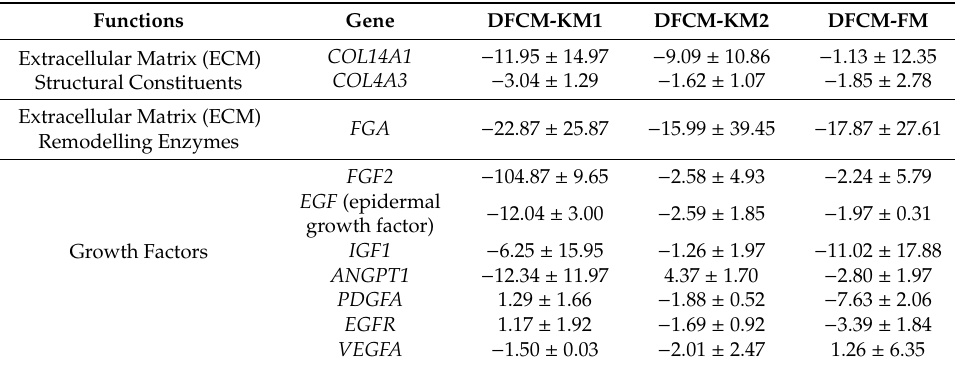
Table 3. Of down-regulated genes in DFCM groups as compared to KM1group (control).